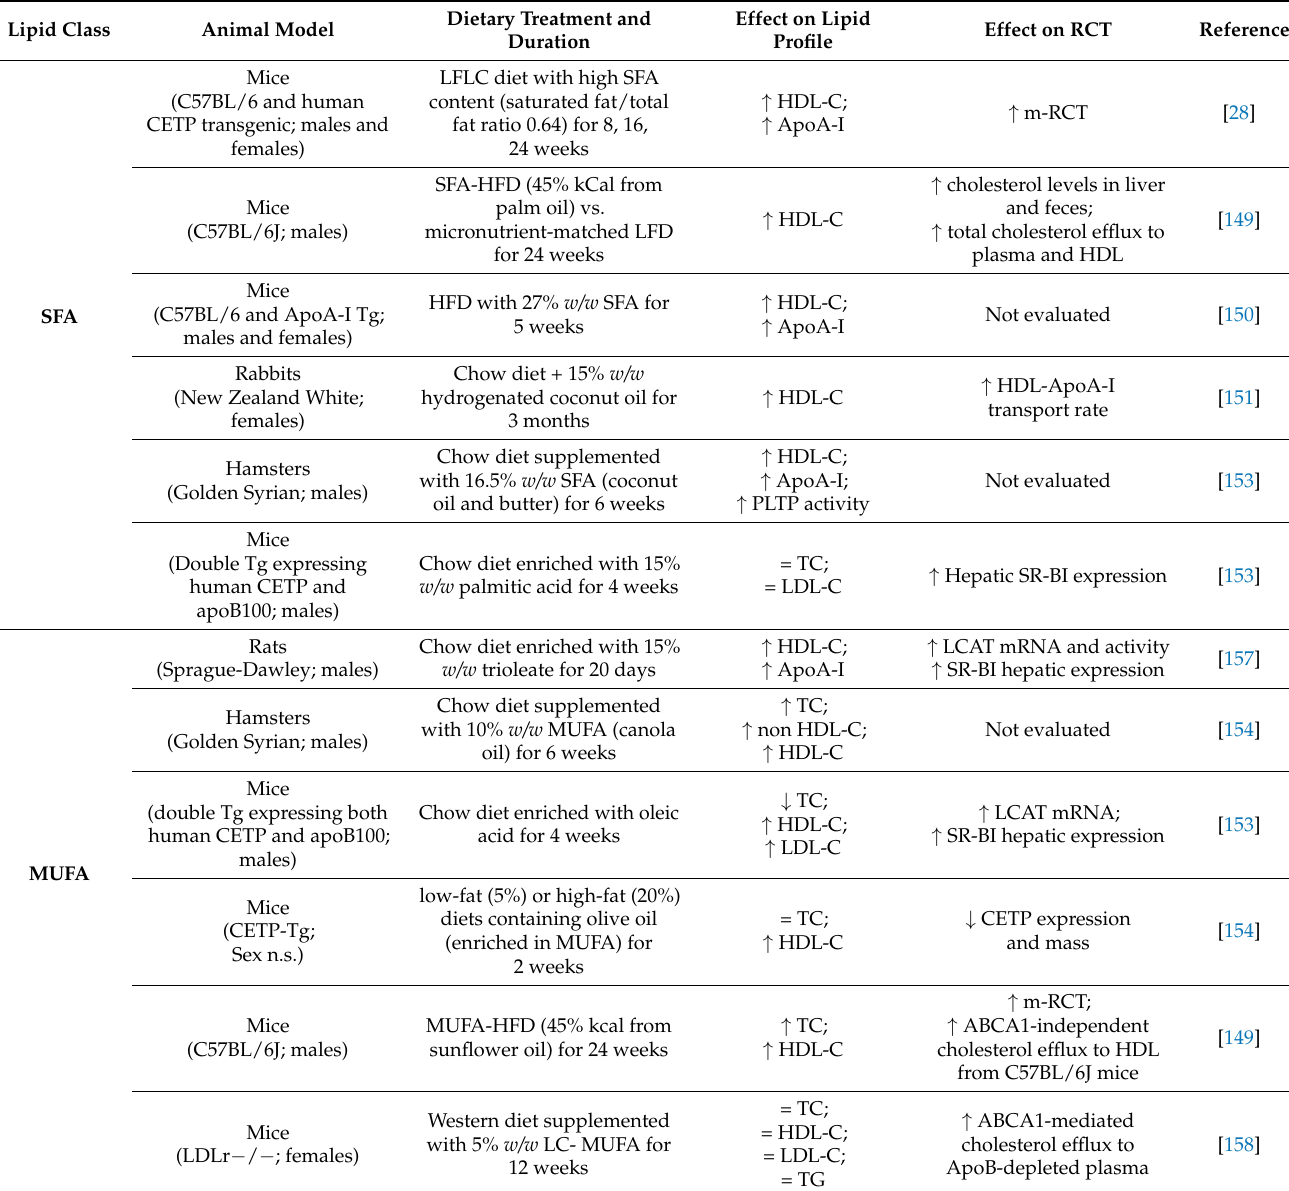
Table 2. Impact of dietary lipid classes on lipid profiles and RCT in animal studies. Dietary Treatment and Lipid Class